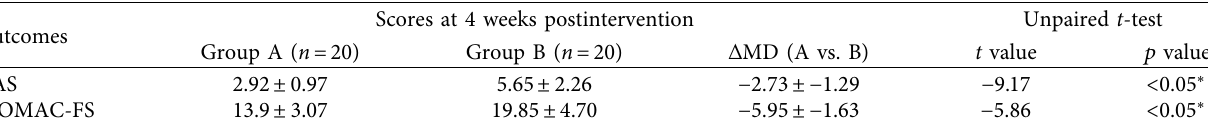
Table 3: Comparison of VAS and WOMAC functional status (mean ± SD) scores between Groups A and B using unpaired t -test. Outcomes